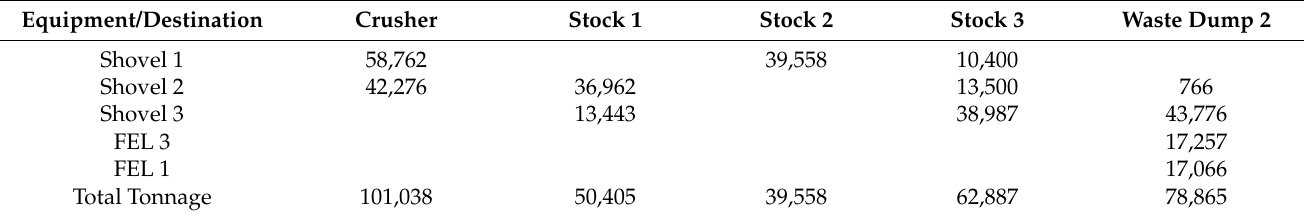
Table 5. Results to replicate by the simulation.